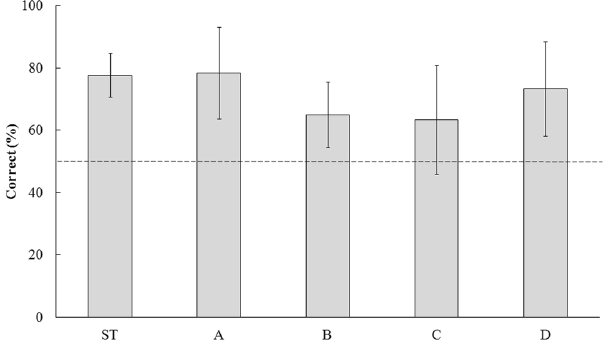
Figure 2. Ratios of correct responses in the standard trials (ST) and the four types of probe trials in the second stage. Proportion of conditioned correct choices for the 5 subjects in the second stage in standard trials (150 trials per subject) and in each type of probe trial (10 trials per subject): ( A ) the same horizontal portion of the face as shown in the standard trials but with novel faces; ( B ): the other horizontal half of the same faces used in the standard trials; ( C ): the other horizontal half of the novel faces; ( D ): the left half (vertical) of the same faces used in the standard